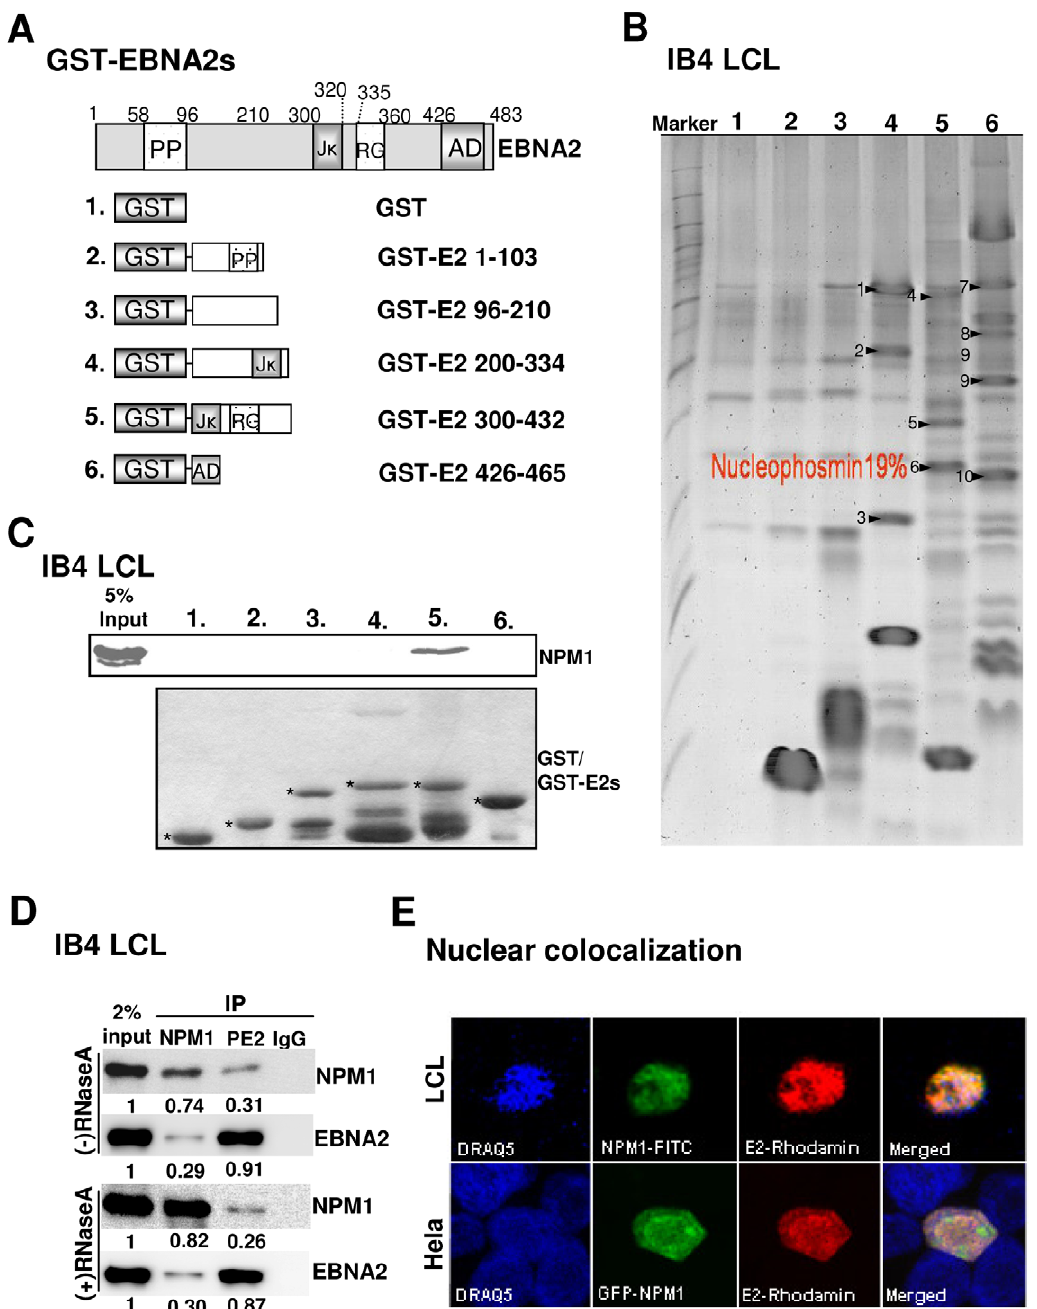
Figure 1. Protein-protein interactions mediated by EBNA2 and NPM1 in vitro and in vivo. A). Schematic depiction of the GST-EBNA2 fusion proteins (GST-E2s). B). IB4 cell lysates were pulled down by similar amounts of each protein bait and resolved on a 4–20% gradient SDS-PAGE gel. Unique gel bands were visualized by staining with Coomassie blue and excised for LC-MS/MS analysis. The NPM1 band is marked with arrowhead 6. C). The samples prepared in (B) were additionally immunoblotted with the NPM1 antibody. The amounts of GST or GST-E2 fusions were determined by Coomassie blue staining, and each is marked with an individual asterisk. D). IB4 cells (10 7 ) were subjected to IP analysis using antibodies for EBNA2 (PE2), NPM1 (C-19), or IgG control, and the immunoprecipitated proteins were identified by Western blot with 2% input of EBNA2 and NPM1 as loading controls. The relative expression of each protein was quantified by UN-scan and determined as a percentage of input. E). The immunofluorescent (IF) analyses were carried out using antibodies for EBNA2 (v-C20) and NPM1 (C-19) followed by counterstaining with a goat anti- mouse antibody conjugated to FITC (Green) or a donkey anti-goat antibody conjugated to rhodamine (red). Confocal images for EBNA2 (E2; Red) and NPM1 (Green) from LCL (upper panels) or HeLa cells (bottom panels) that had been co-transfected with EBNA2 and GFP-NPM1 expression vectors are shown. Nuclei were counterstained with DRAQ5 (blue).